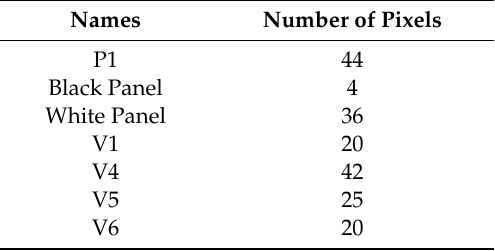
Figure 4. The SIM.GA dataset color image of Viareggio City, Tuscany, Italy. Table 2. Details of the panels and vehicles used as targets in the SIM.GA dataset.